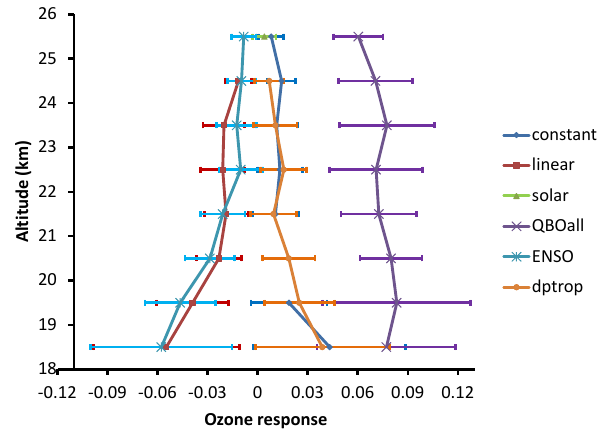
Fig. 3. Ozone response and uncertainty (95% CI, accounting for autocorrelation of the residuals) to various predictors (see Eq. (7) and the text for formula for response and its uncertainty, except for constant, whose response and its uncertainty are the fit coefficient and its 95% CI). The linear response is proportional but not equal to the decadal trend. QBOall is the combined ozone response to all QBO terms (including harmonics).